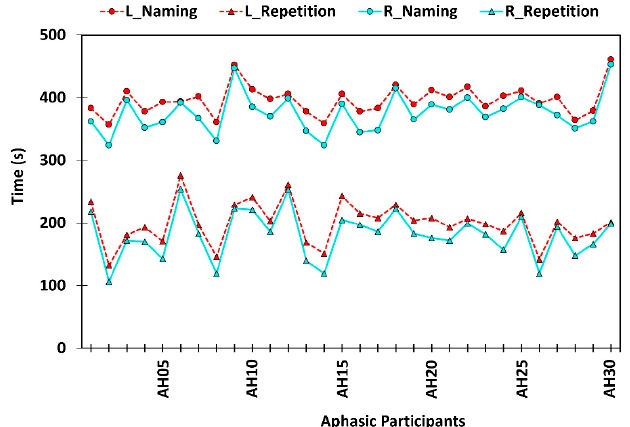
Figure 7. Time spent on confrontation naming and repetition tasks using live auditory model (L) and pre-recorded auditory model (R).